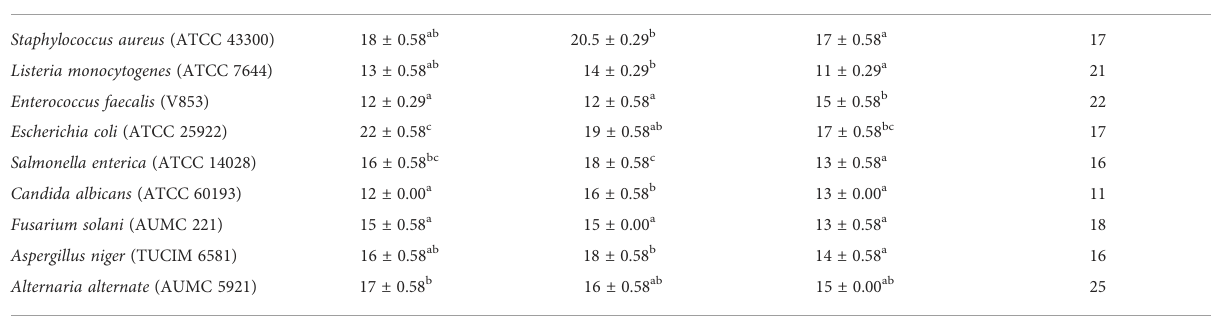
TABLE 1 Antimicrobial (antibacterial and antifungal) activity of gold nanoparticles biosynthesized using macroalgae C. myrica, C. trinodis, and C. prolifera against tested pathogenic bacteria and fungi evaluated by the inhibition zone diameter in mm. Test microorganisms